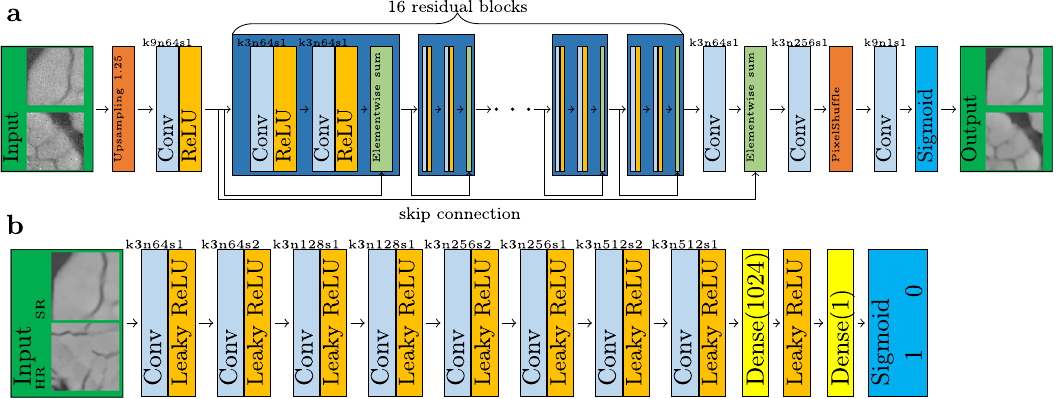
Fig. 1 Network architectures. Modi fi ed versions of the architectures described in Ledig et al. (2017) 33 for the generator G ( a ) and discriminator D ( b ) considered in the present paper. The labels above convolutional layers (Conv) indicate the kernel size ( k ), the number of feature maps ( n ) and the stride ( s ). For example, the label k9n64s1 indicates a convolutional layer with kernel size k = 9, number of feature maps n = 64, and stride s =